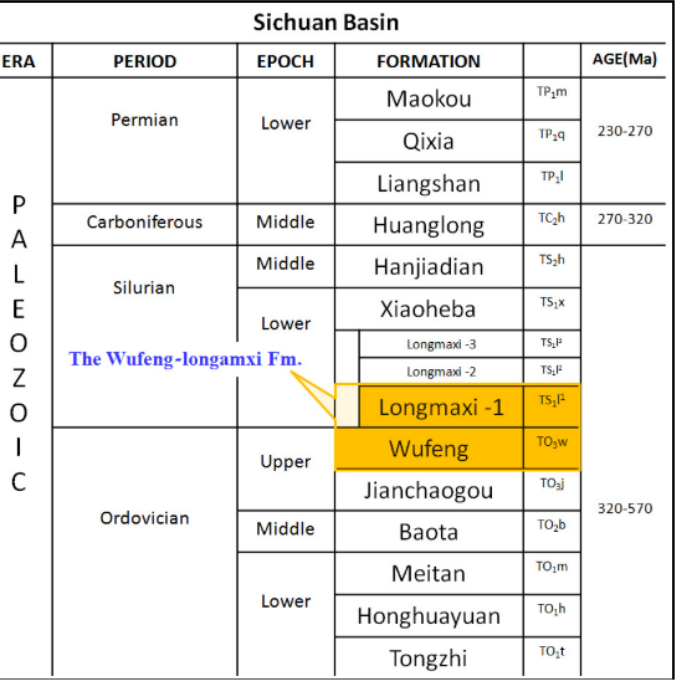
Figure 6. The location of the Fuling shale gas field.